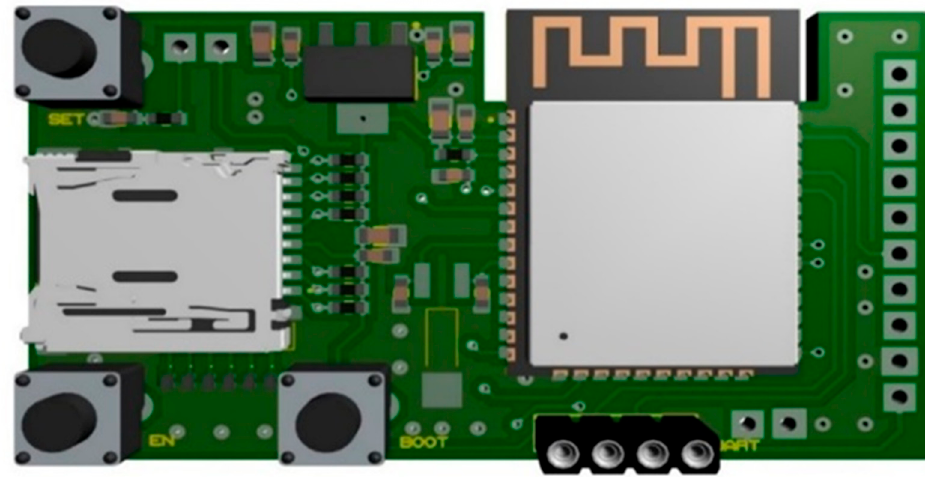
Figure 3. Processing and communication circuit board.